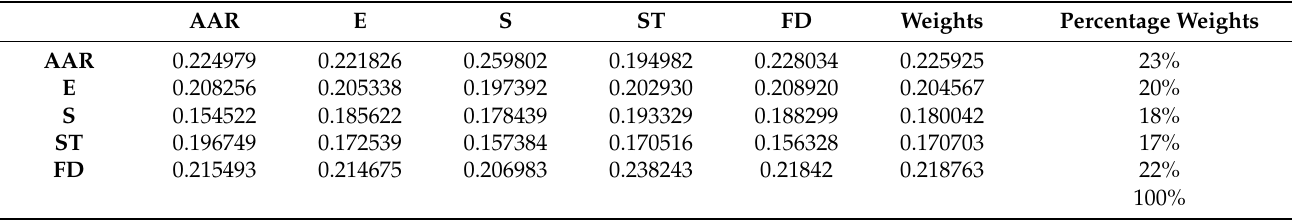
Table 2. Standard matrix for hazard